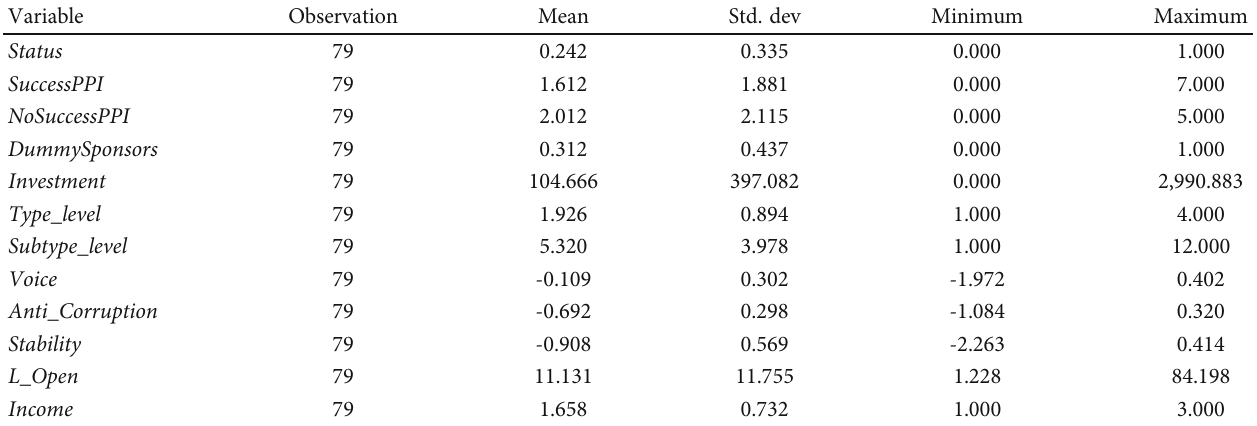
Table 6: Summary statistics of variables in regression model 1.